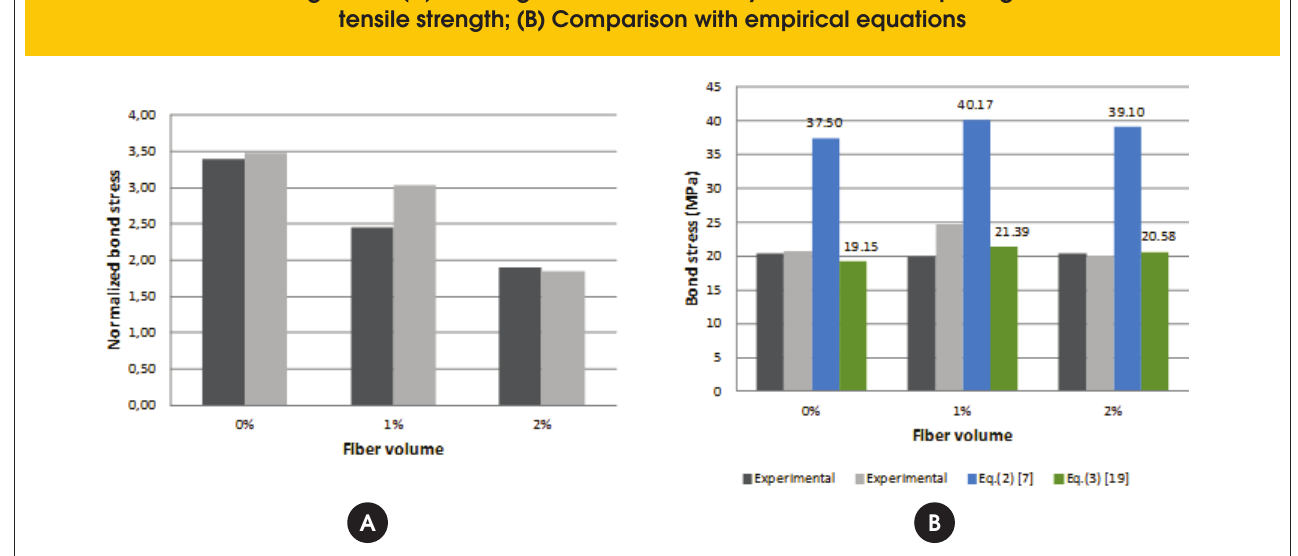
Figure 5 – (A) Bonding stress normalized by the concrete's splitting tensile strength; (B) Comparison with empirical